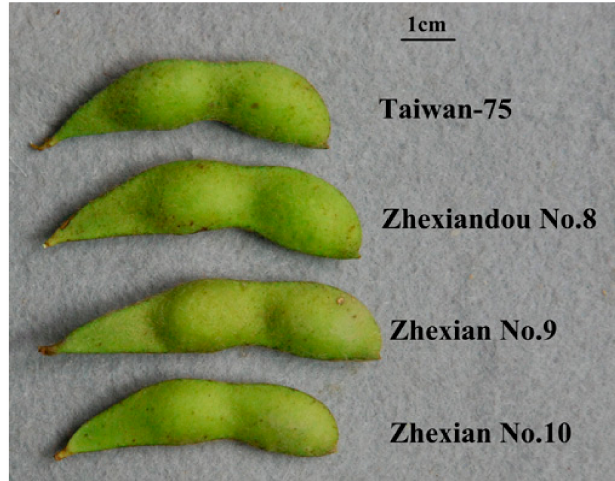
Figure 1. Fresh pods of the four